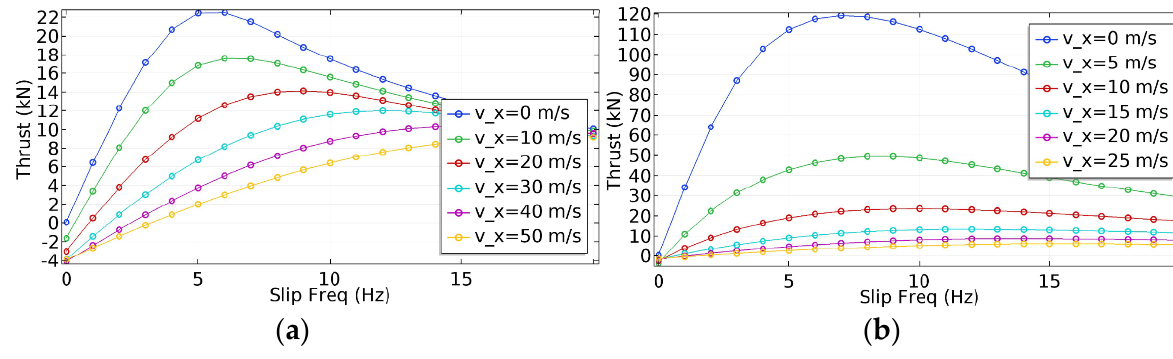
Figure 12. LIM characteristics obtained for the current supply ( I = 550 A) ( a ) and the voltage supply ( V = 460 V) ( b ) [70].